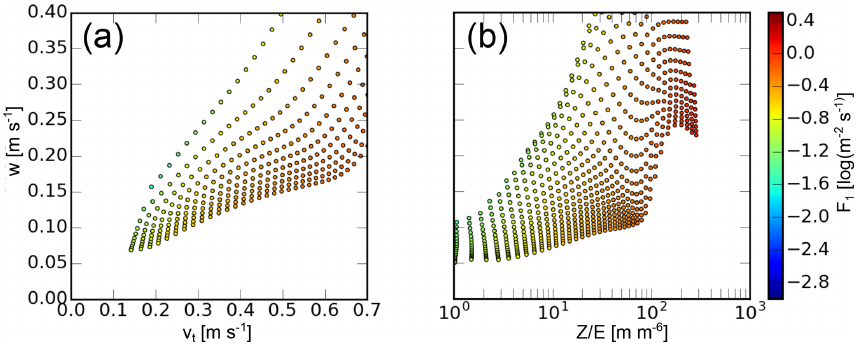
Figure 7. Example of a retrieval of F 1 based on m = (v t ,w) (a) and m = (Z/E,w) (b) for the combined particle type plate-like.